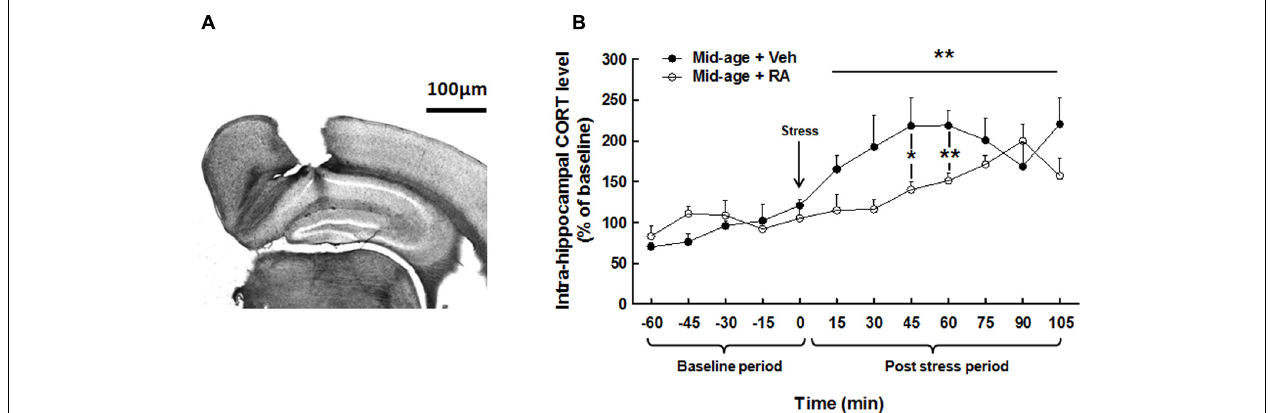
Hippocampal CORT concentration was similar for all groups during basal period. During post-stress period, RA-treated group showed a decrease in hippocampal CORT levels particularly at 45 and 60 min after stress. * p < 0.05, ** p < 0.01, by two-way ANOVA with repeated measures and one-way ANOVA, n = 6–7 per group.